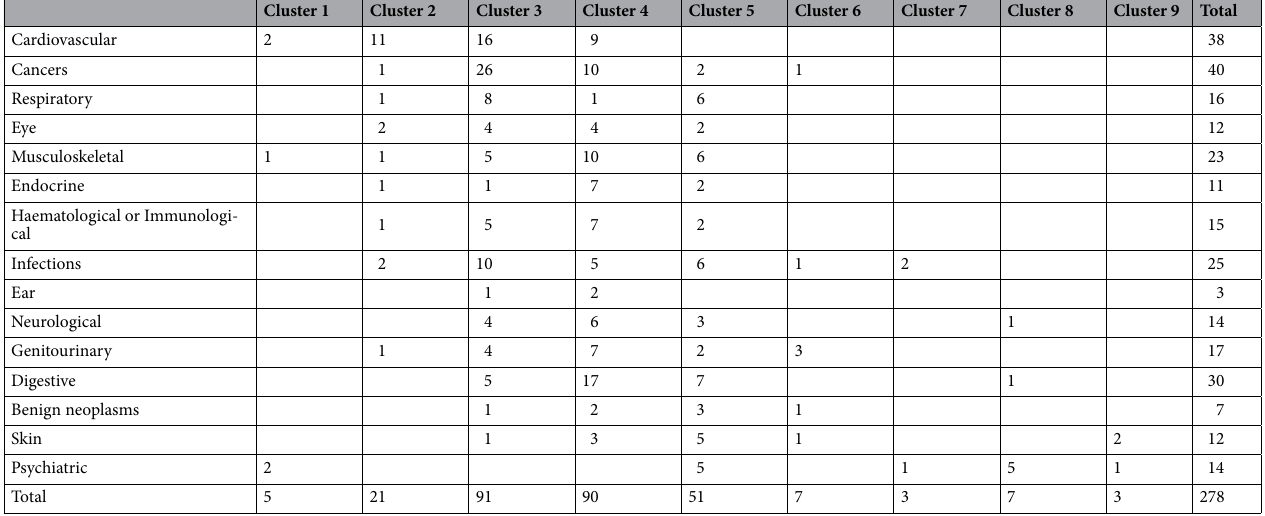
Table 1. The relationship between disease category and age curve cluster for 278 diseases. The number of diseases is shown for each age curve cluster and disease